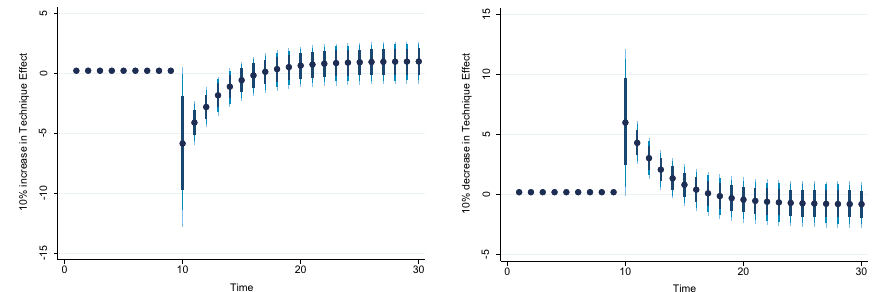
Fig. 2 The impulse response plot for technique effect and CO 2 emissions. This figure shows a 10% increase and a decrease in technique effect and its influence on CO 2 emissions where dots specify average prediction value. However, the dark blue to light blue line denotes 75, 90, and 95% confidence interval, respectively